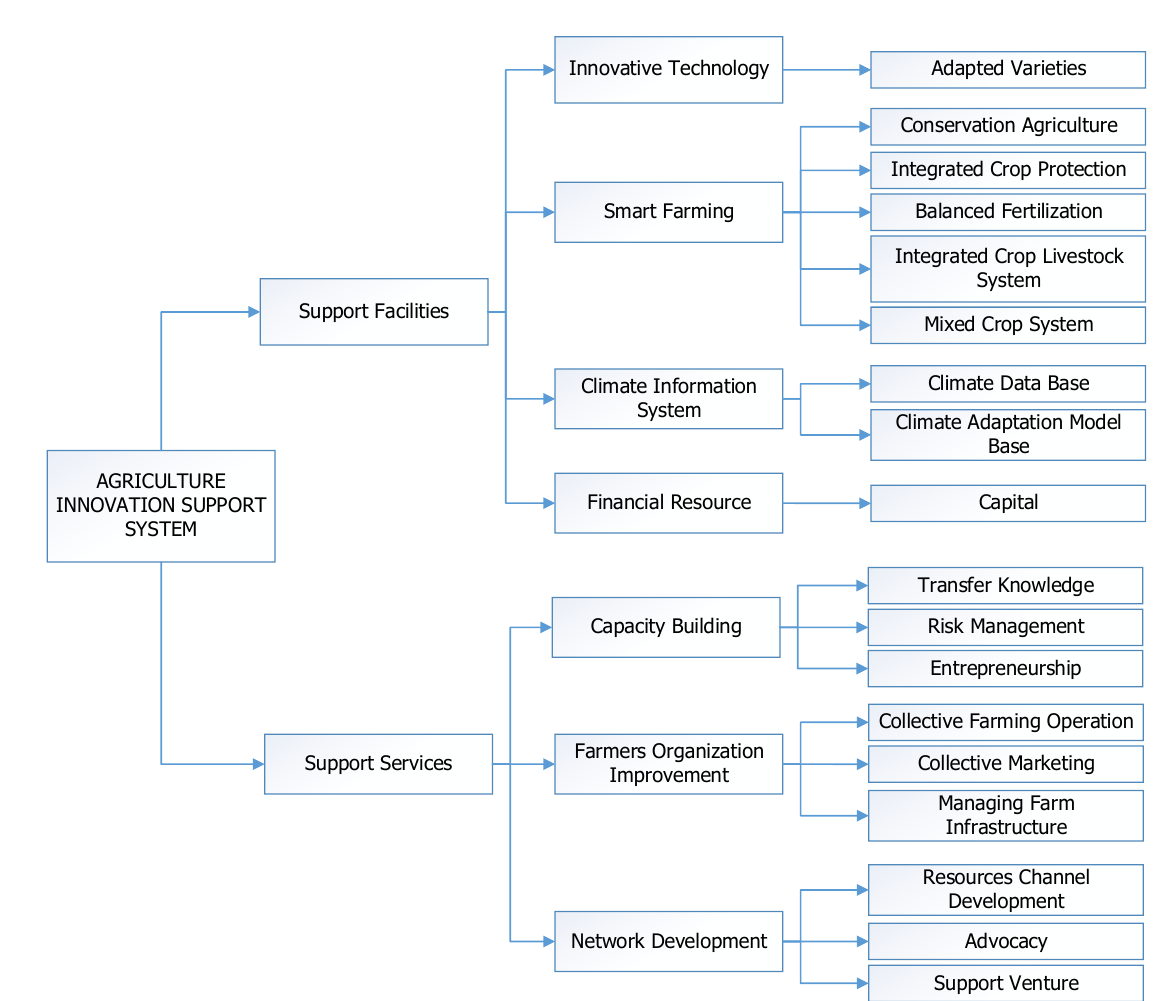
Figure 5. Proposed model of agricultural innovation support system.